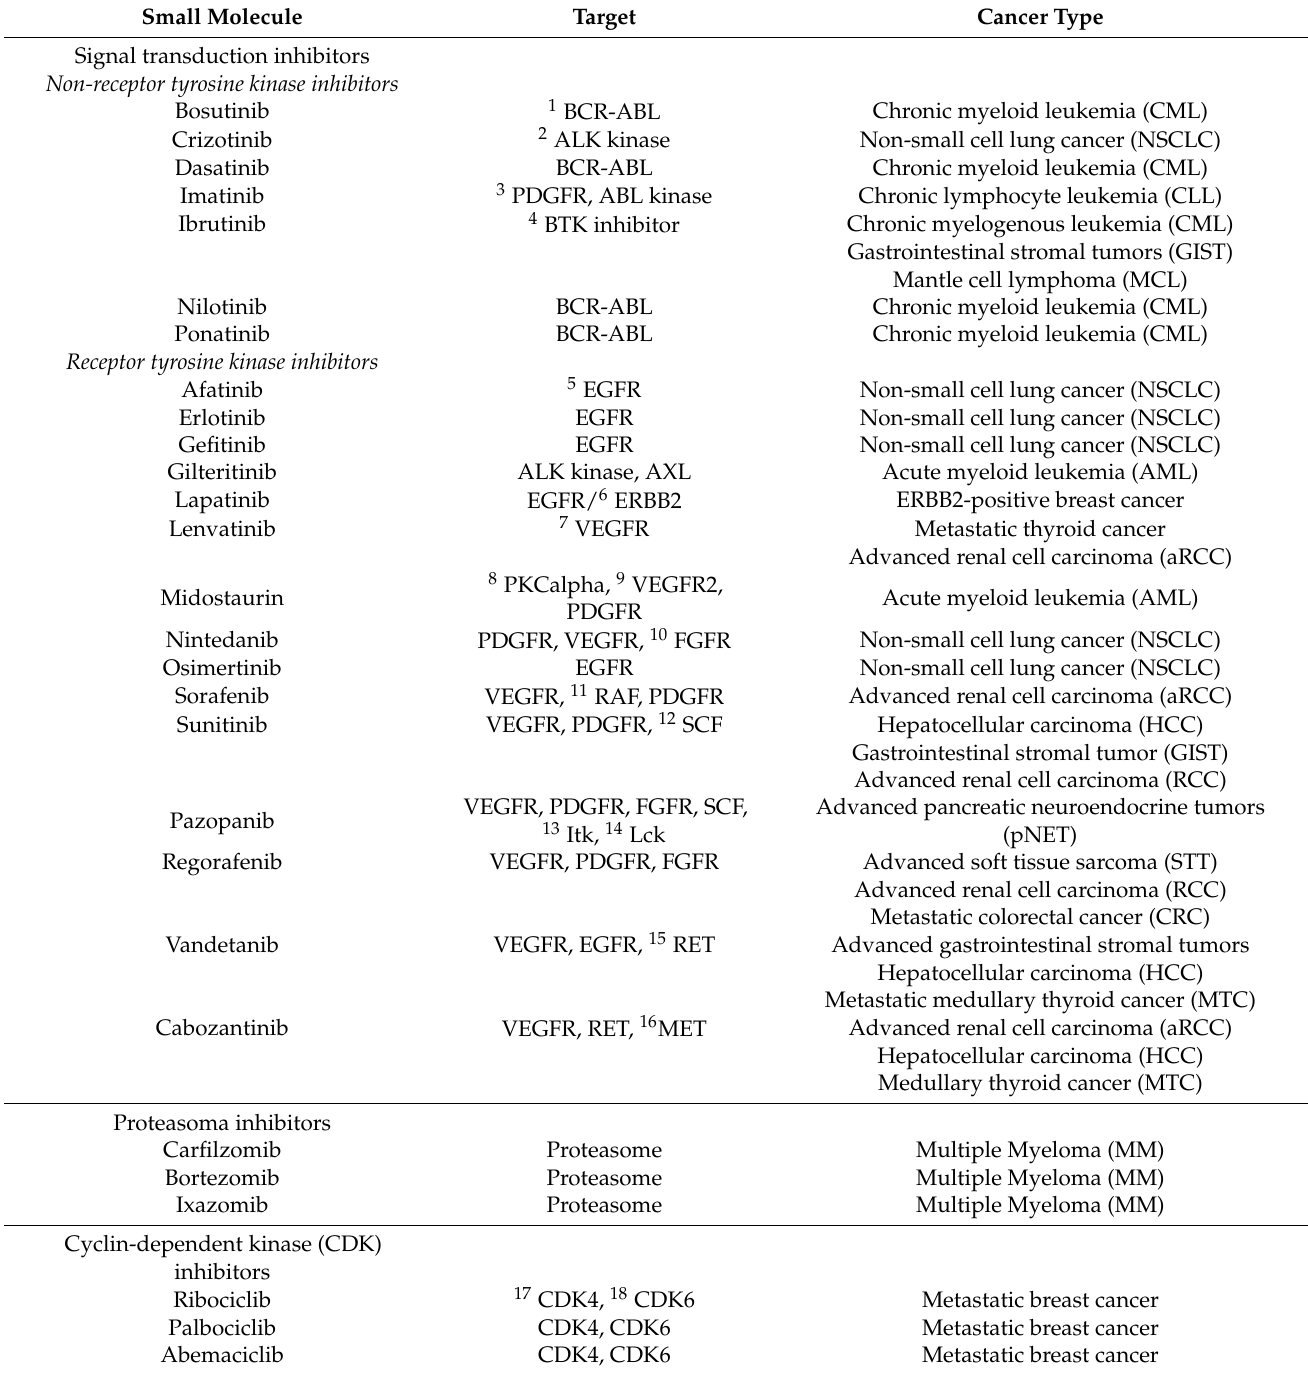
Table 2. List of European Medicines Agency approved small molecule inhibitors used in clinics [63]. Small